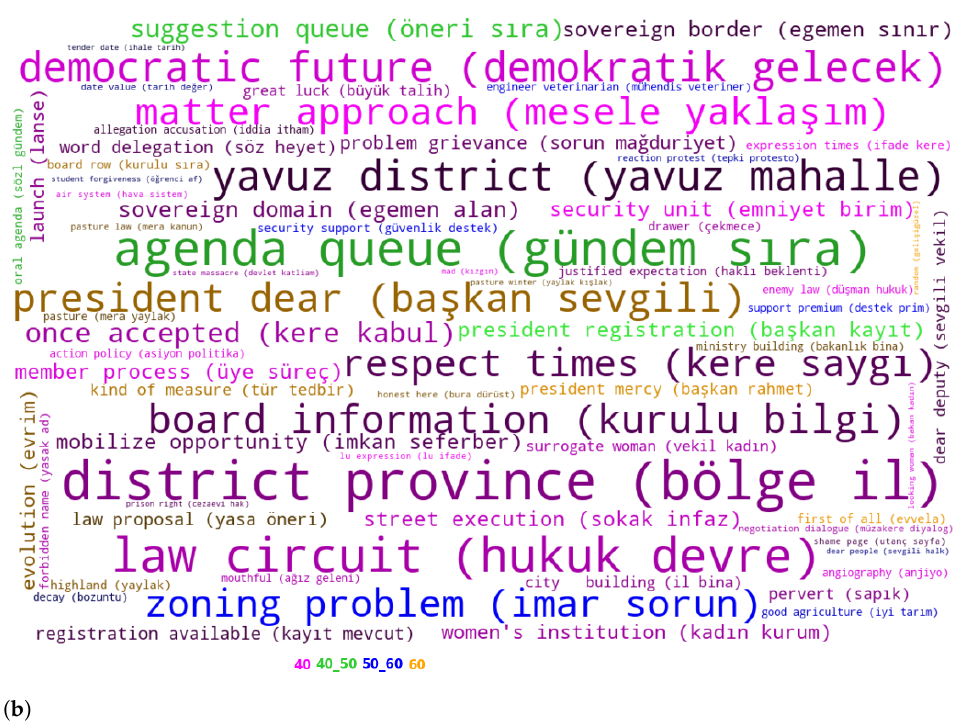
Figure 2. ( a ) Confusion matrix for age classification with TF-IDF (word) _SVM., ( b ) Best terms of age trait of